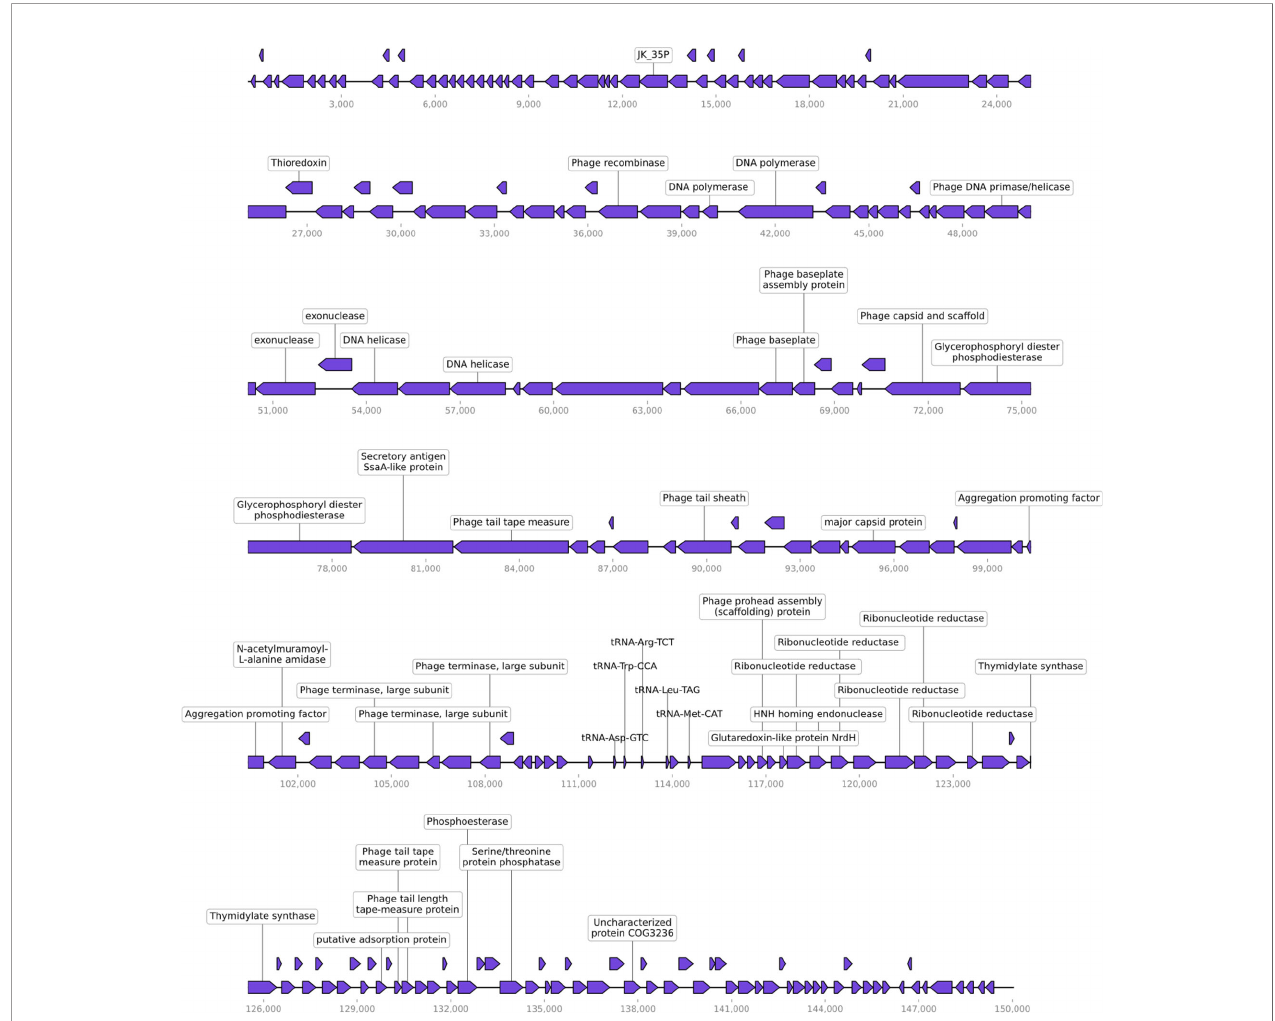
FIGURE 2 | Genomic characterization of vB_EfaM_LG1. LG1 is a dsDNA phage with 231 proteins predicted based on sequence homology and fi ve tRNA